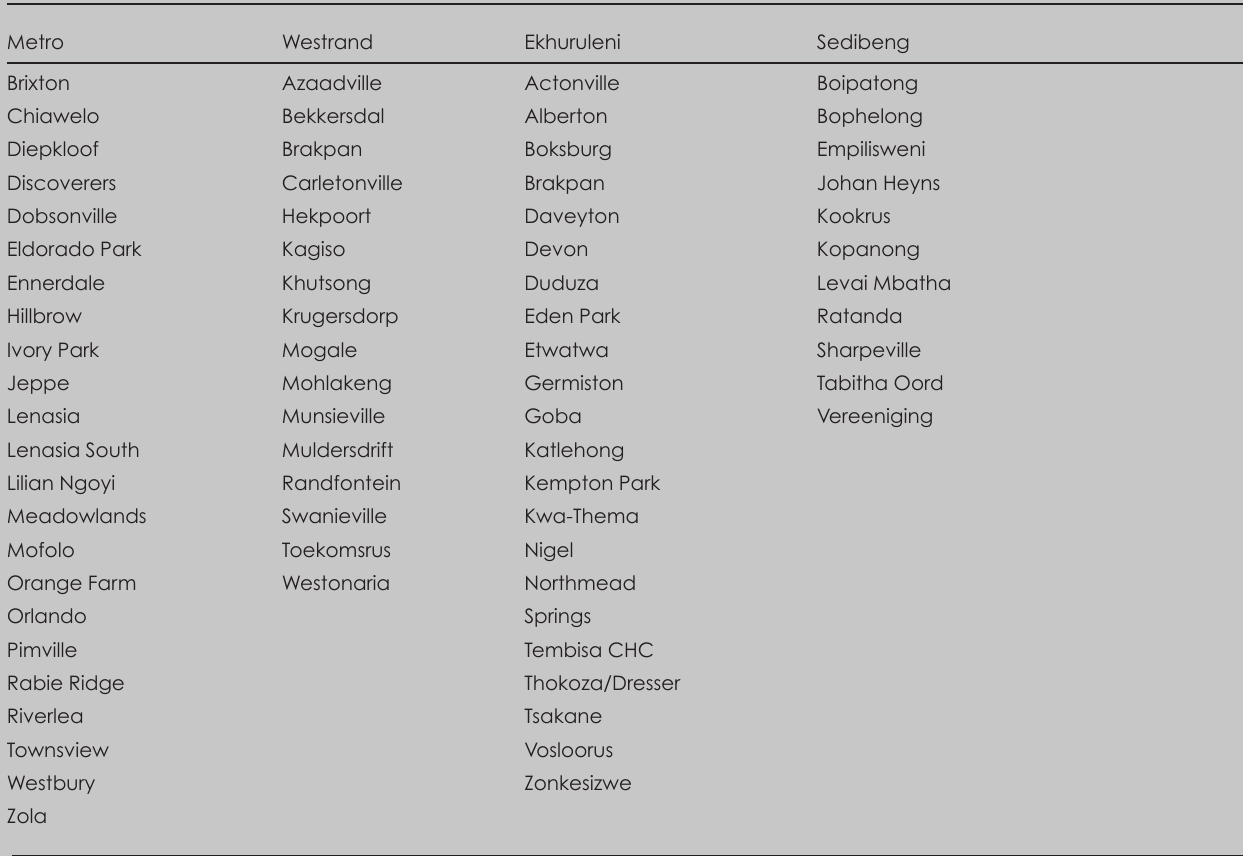
Table I. Adult clinics in southern Gauteng Metro